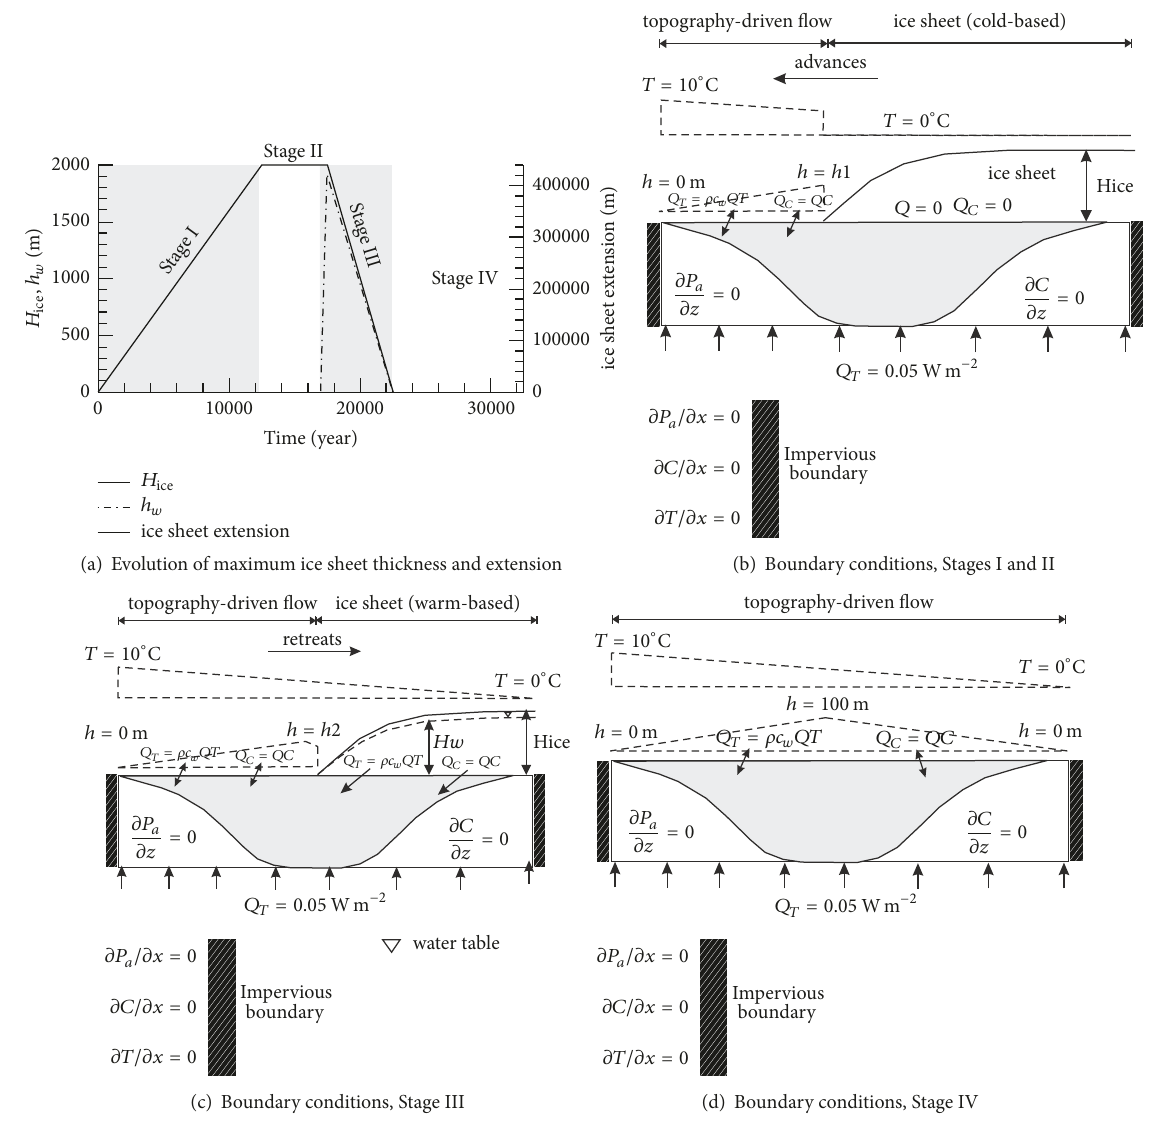
Figure 3: Reproduced from [9] with permission. (a) Glaciation scenario used to specify boundary conditions along the top boundary of the model domain. (b), (c), and (d) Model boundary conditions for flow, solute, and energy transport equations. h: hydraulic head [m]; 𝑇 : temperature [ ∘ C]; 𝐶 : concentration [molL −3 ]; 𝑄 : volumetric recharge [L −3 T −1 ]; 𝑄 𝑐 : solute mass flux [molT −1 ]; and 𝑄 𝑇 : heat flux per unit of surface [ET −1 L −2